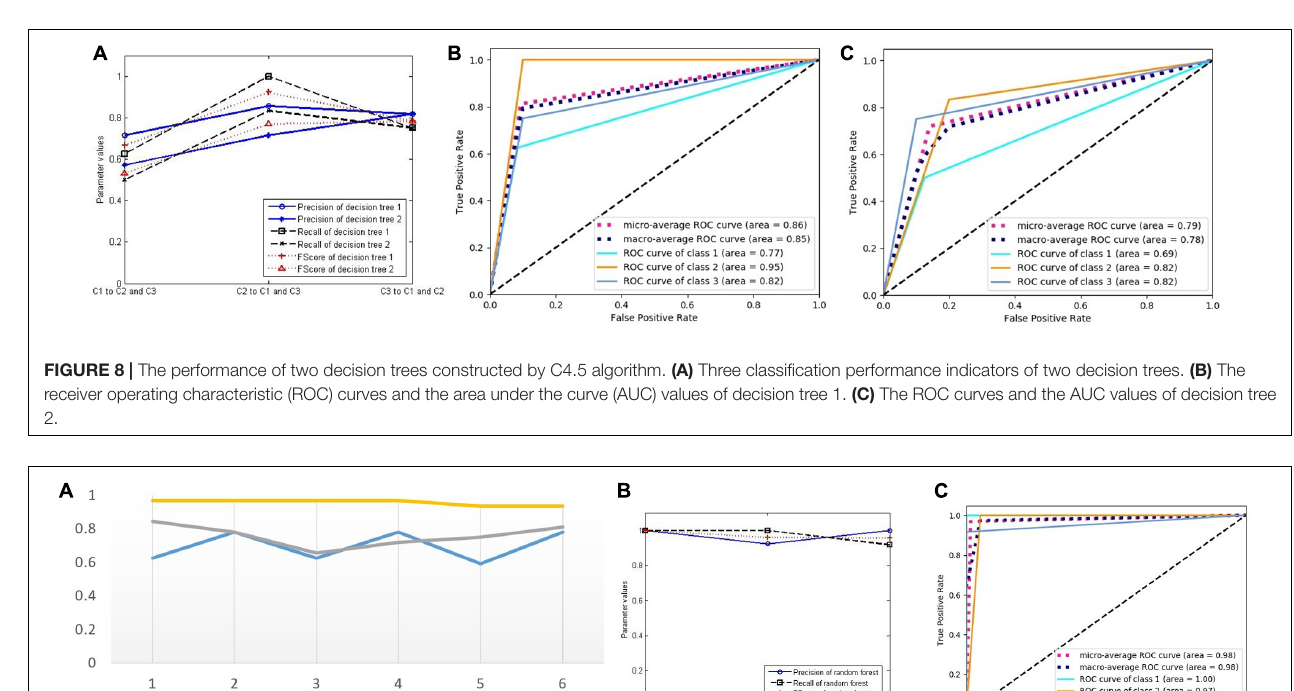
FIGURE 7 | The performance of two long short-term memory (LSTM) classifiers. (A) Three classification performance indicators of two LSTM classifiers. (B) The receiver operating characteristic (ROC) curves and the area under the curve (AUC) values of LSTM classifier 1. (C) The ROC curves and the AUC values of LSTM classifier 2.